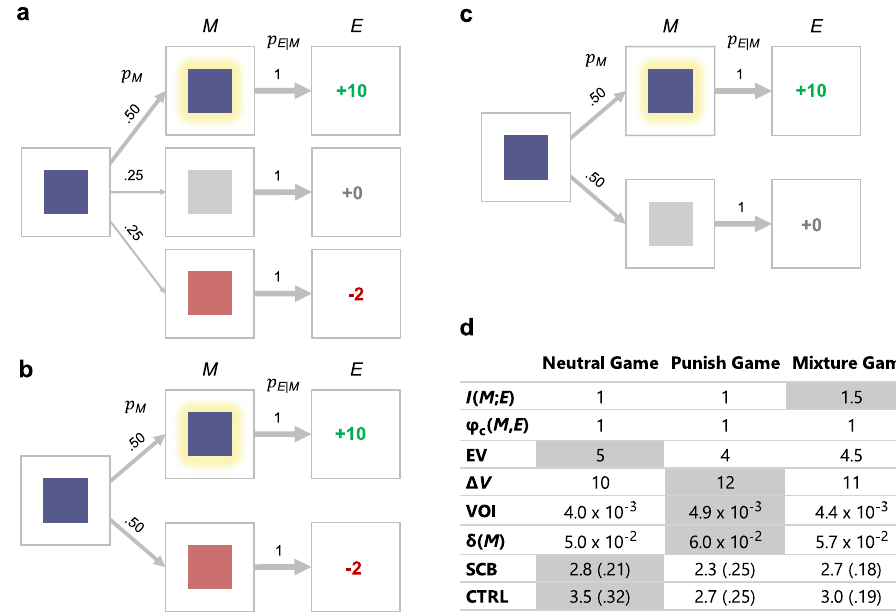
Fig. 6 Design of experiment 3. In experiment 3, each version of the tile game shared the following features: ( i ) the tile glowed when activated (instead of changing colors, as in experiments 1 and 2), ( ii ) p M ð hit Þ was always set to .5, and ( iii ) p E j M jackpot j hit ð Þ was always set to 1. a Mixture game. Missing the tile results in a 50% chance of the tile turning red, indicating a $0.02 loss (i.e., a deduction of $0.02 from the player ’ s bonus fund), and a 50% chance of the tile turning gray (indicating no jackpot); M has three possible values ( hit , gray , and red ) and E has three possible values ( jackpot , no jackpot , and penalty ). b Punish game. Missing the tile results in a 100% chance of the tile turning red (indicating a $0.02 less); M has two possible values ( hit and red ) and E has two possible values ( jackpot and penalty) . c Neutral game. Missing the tile results in a 100% chance of the tile turning gray, indicating no jackpot; M has two possible values ( hit and gray ) and E has two possible values ( jackpot and no jackpot) . d Key statistics associated with each version of the game. The values of I ð M ; E Þ , expected value (EV), marginal value ( Δ V ), and the correlation between M and E ( φ ð M ; E Þ ) were computed analytically. The values for temporal c difference prediction error ( δ M ð Þ ) and value of information (VOI) correspond to the average output of 1,000 simulations. The values of skill-challenge balance (SCB) and controllability (CTRL) are the empirical means and standard errors obtained from self-report measures of the corresponding constructs. The largest value of each variable is highlighted in